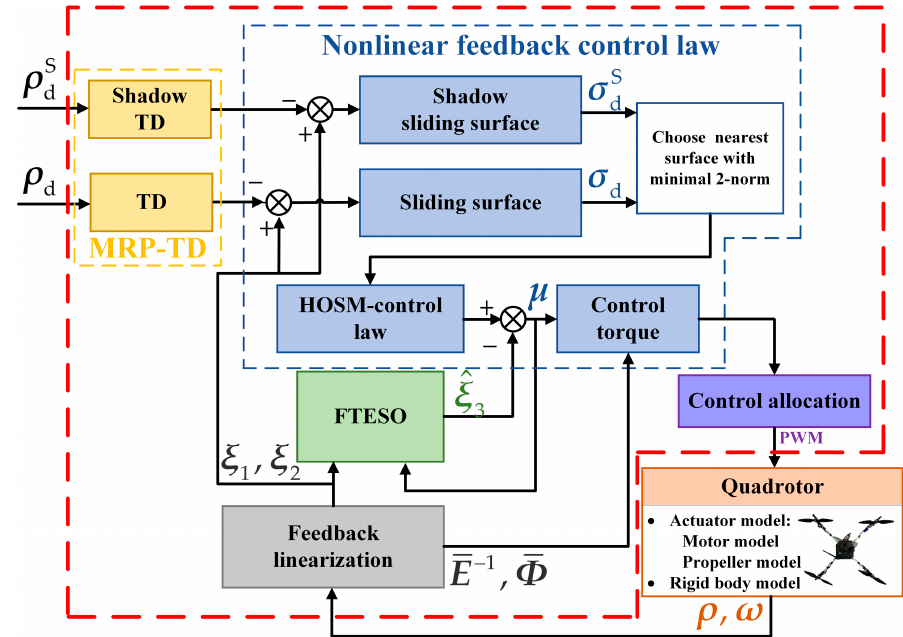
Figure 7. Block diagram of the proposed fixed-time active disturbance rejection control (FTADRC) attitude control scheme.